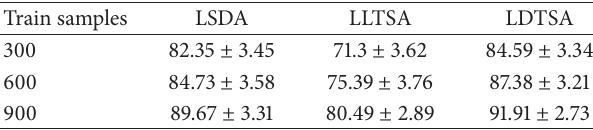
Table 2: Average classification rates (%) and standard deviations Swedish plant leaf